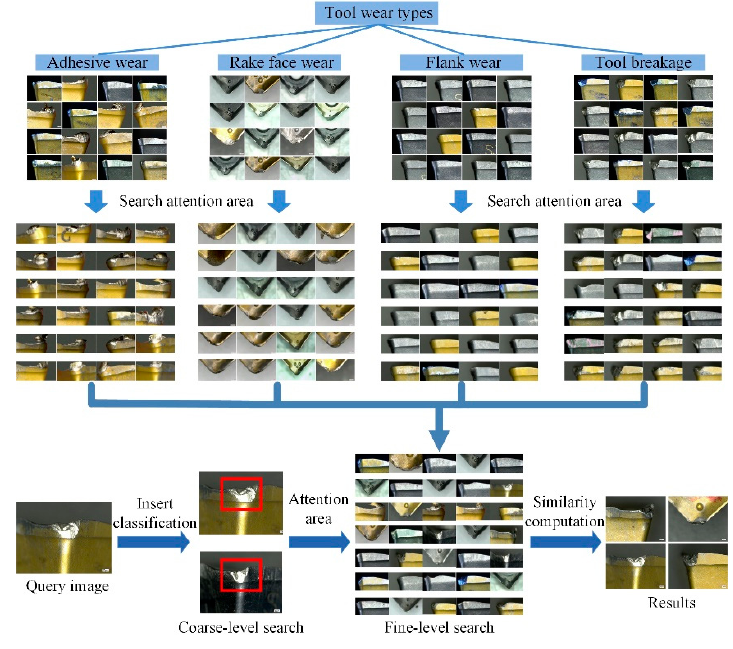
Figure 8. The partial images of the datasets and the process of depth search.